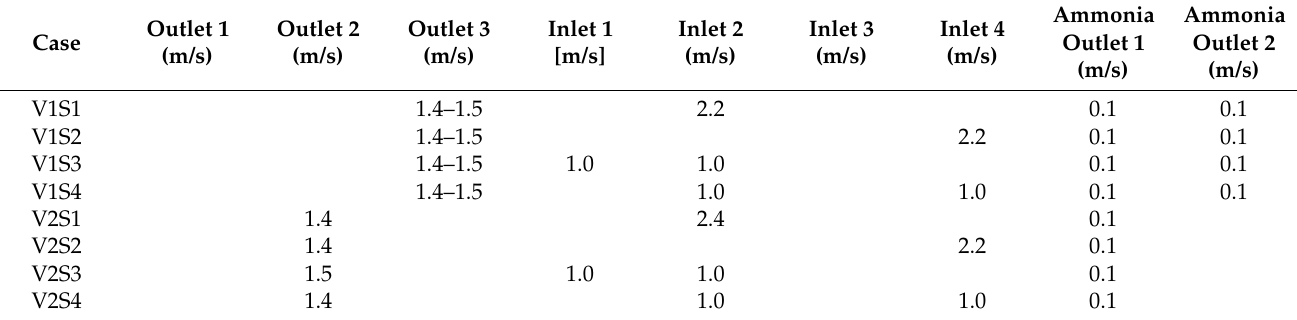
Table 2. Analyzed cases of ammonia release and work of the ventilation system. V—variant;